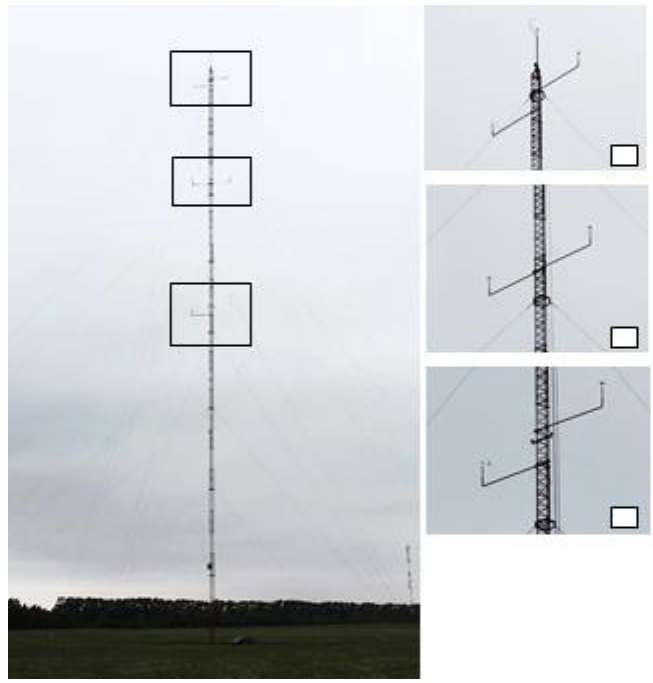
Figure 8. Photographs looking west-southwest and south of the mast The sensors are set at different heights in order to measure the wind speed and wind direction at several tips. By using, the data of the anemometers in the shear Equation 1, the wind shear α can be precisely calculated. The wind shear Equation 1 should be filled by the proper data, where h 2 is the height of the higher anemometer 99 m, h 1 is the height of the lower one 94.3 m, V 2 is the speed at h 2 and V 1 is the speed at h 1 . Then this repeated for the anemometers at heights 72.6 m and 94.3 m [11]. The average wind shear is then calculated by averaging both the shears.